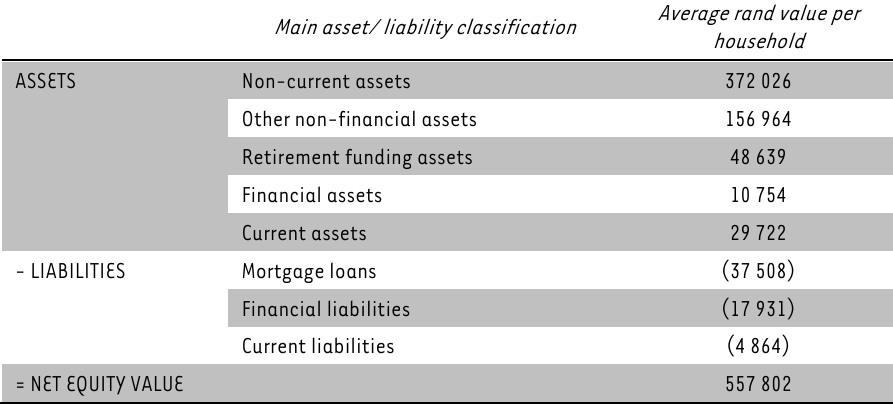
TABLE 2: Rand value of household net